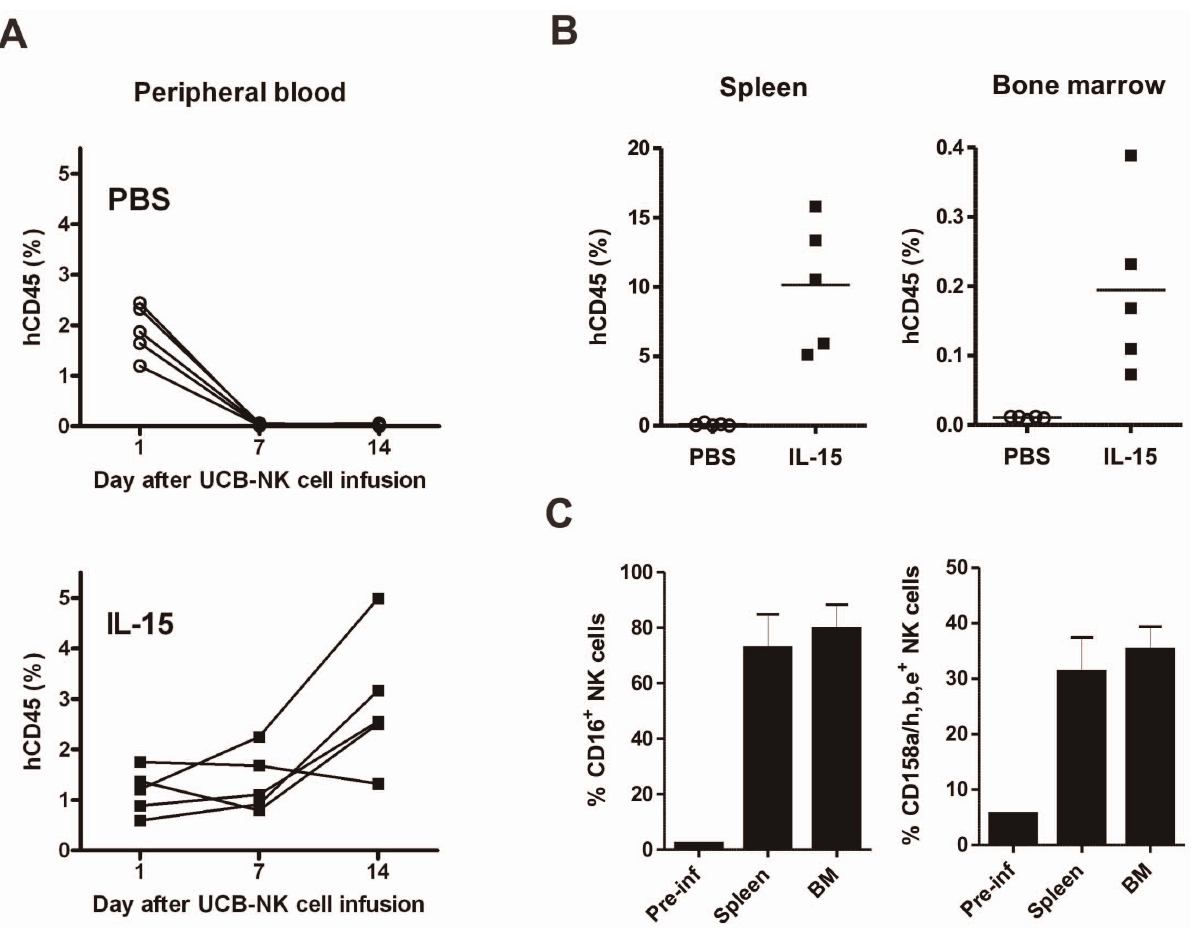
Figure 5. Low-dose IL-15 mediates efficient UCB-NK cell survival and expansion invivo . Adult NSG mice were injected i.v. with 5 6 10 6 UCB-NK cells with or without supportive IL-15. Recombinant human IL-15 was administered every 2–3 days for 2 weeks at the dose of 0.5 m g/mouse/ injection, starting the day of UCB-NK cell infusion. (A) Percentages of circulating human CD45 + cells in all CD45 + cells were quantified by flow cytometry at the indicated time points. Each line corresponds to one mouse. (B) Percentages of human CD45 + cells in all CD45 + cells quantified in spleen and bone marrow (leg bones) 2 weeks after UCB-NK cell infusion. (C) Expression of CD16 and CD158a/h,b,e on UCB-NK cells before and 2 weeks after infusion into NSG mice. Percentages were determined on human CD45 + CD56 + NK cells isolated from spleen and bone marrow. Graphs show the mean 6 SD of 5 mice.